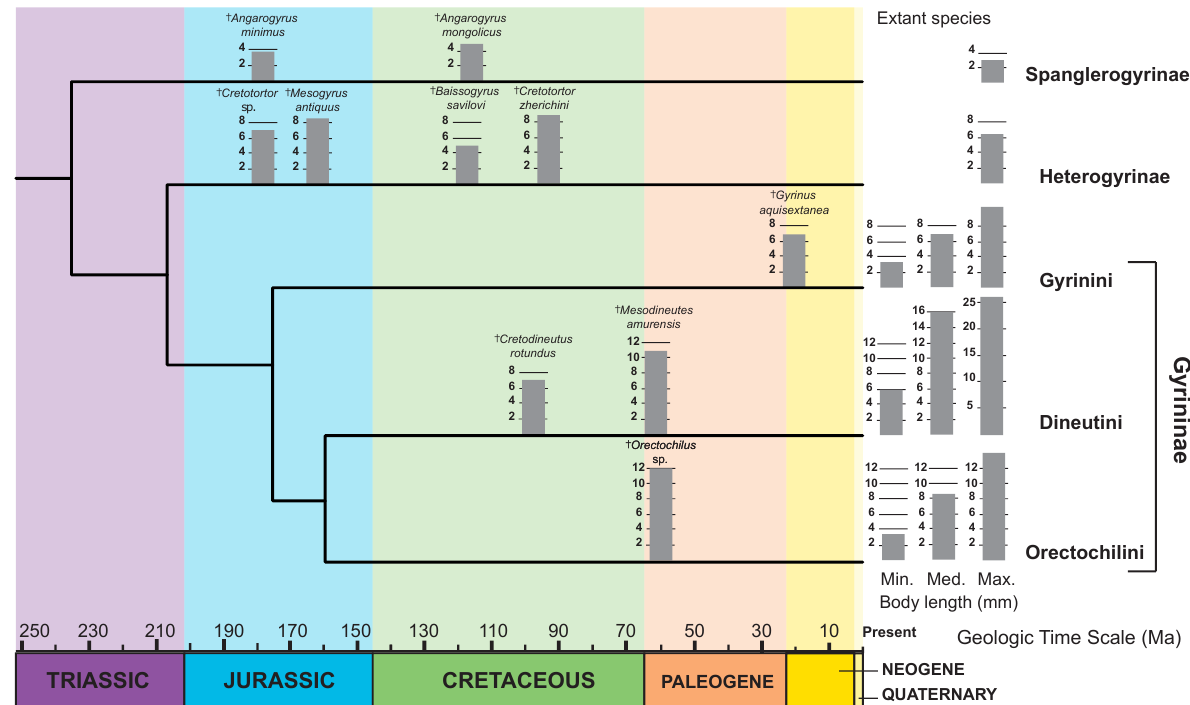
Figure 9. Histograms of species minimal sizes for the different genera of whirligig beetle ranked according to median minimal size. Lower panel points the minimal sizes of the species belonging to genera with only few species. Inlet show the histogram of the minimal sizes of all whirligig beetle species. Number of species composing the histograms are indicated in brackets. A red line indicates the median.